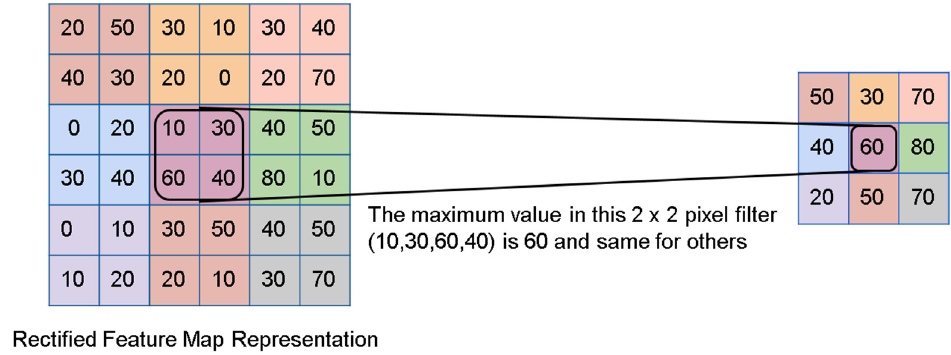
Figure 7. Working of max pooling layer from rectified feature map.